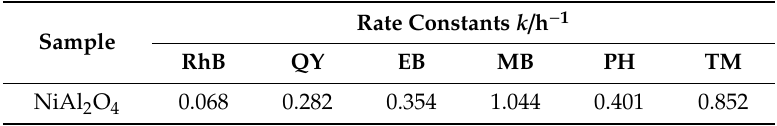
Figure 8. ( a ) Residual concentration ratio (C t / C 0 ) and ( b ) apparent first-order kinetic lines of rhodamine B (RhB), quinoline yellow (QY), eriochrome black (EB), methylene blue (MB), phenol (PH) and thiram (TM) as a function of time under simulated solar light irradiation in the presence of NiAl 2 O 4 . Table 2. The apparent first-order rate constants k (min − 1 ) for the degradation of RhB, QY, EB, MB, PH and TM under simulated solar light irradiation in the presence of NiAl 2 O 4 .